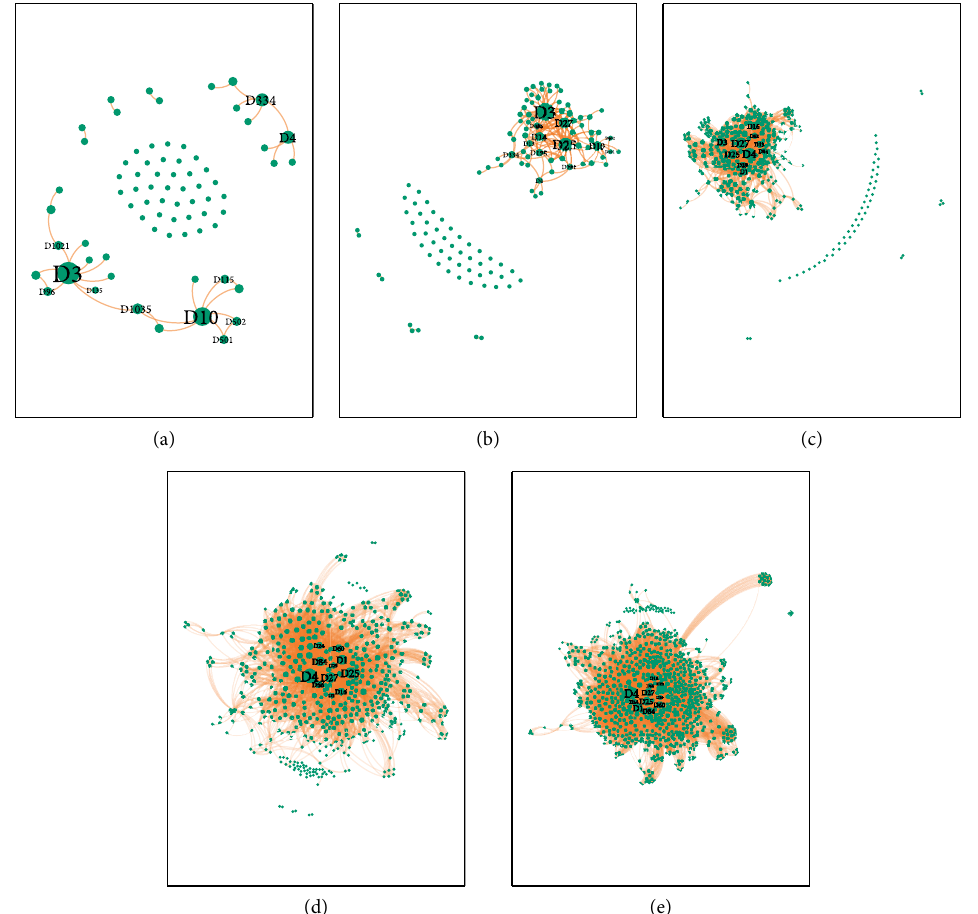
Figure 5: The sub-networks of co-authorship in different stages. (a) 1997, (b) 2002, (c) 2007, (d) 2012, (e)